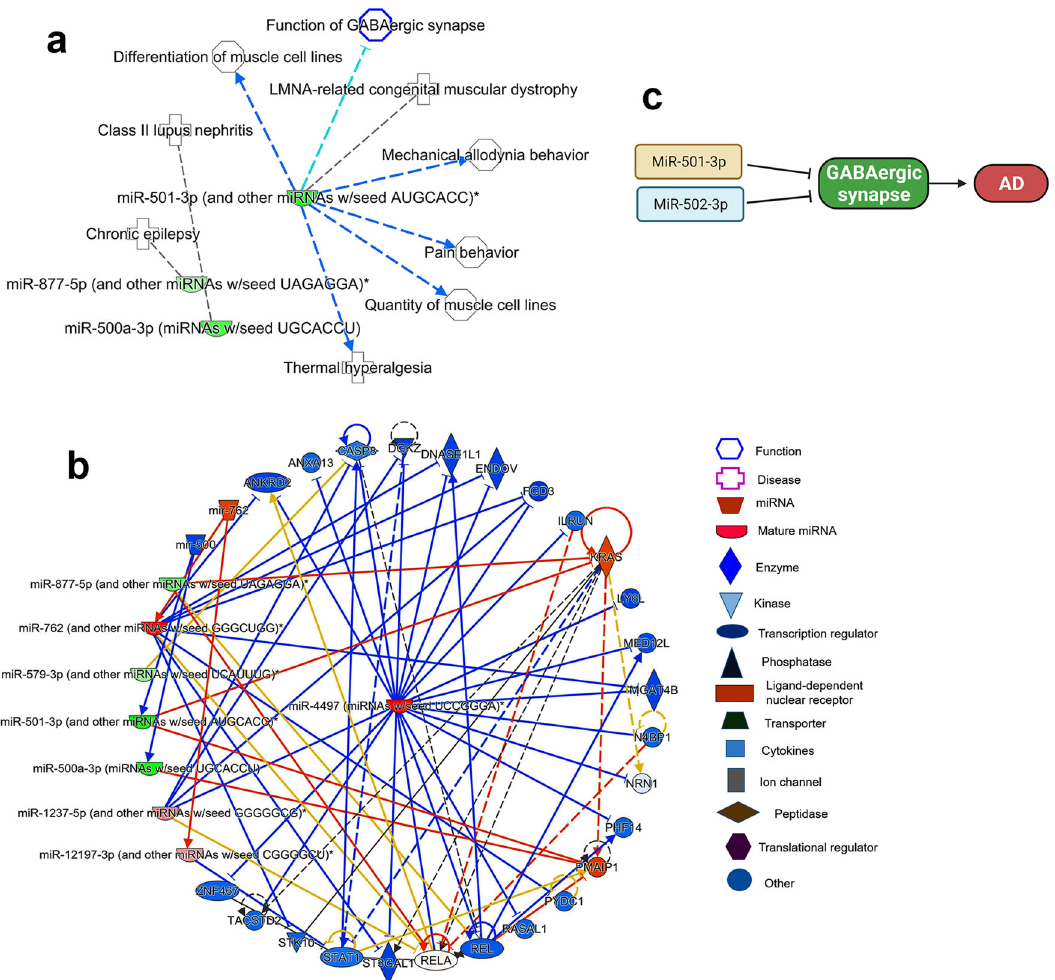
Fig. 6 Ingenuity pathway analysis of synaptosomal miRNAs in AD. a Synaptosomal miRNAs expression network in various human diseases. b MiRNAs target and seed sequences network of synaptosomal miRNAs in the AD and healthy state. Red nodes represent increased expression and green nodes represent a decreased expression of miRNAs. c Possible molecular mechanism of miR-501-3 and miR-502-3p in AD progression via negative modulation of GABAergic synapse. Inhibition of GABARA1 expression by the overexpression of these miRNAs could inhibits the GABAergic synapse function in